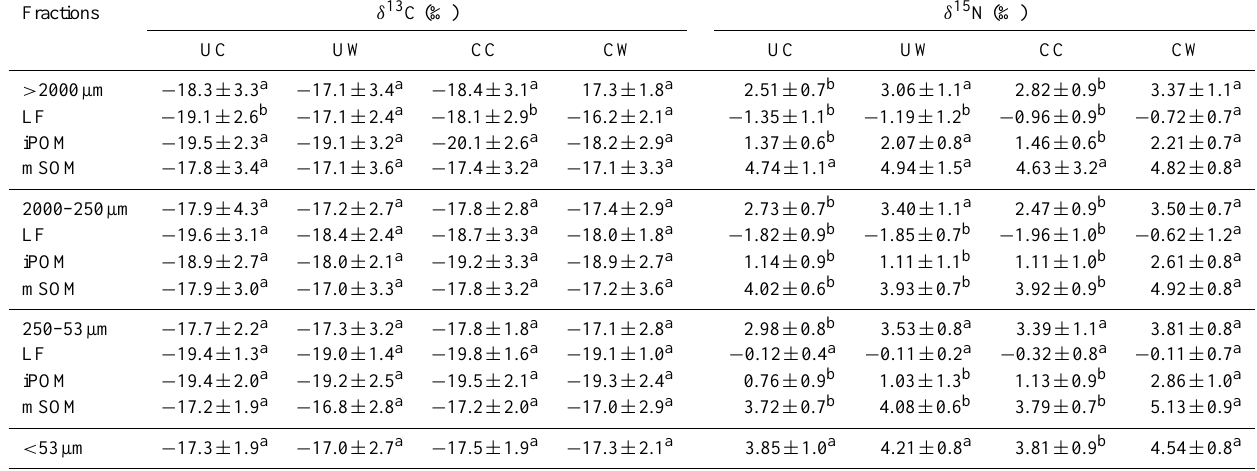
Table 5. δ 13 C and δ 15 N values of soil fractions under four treatments after nine years of warming and clipping. Data are expressed as mean ± SE, n = 6. Different letters indicate statistical significance at P < 0 . 05 among the four treatments. See Table 3 for abbreviations. Fractions δ 13 C (‰) δ 15 N (‰)